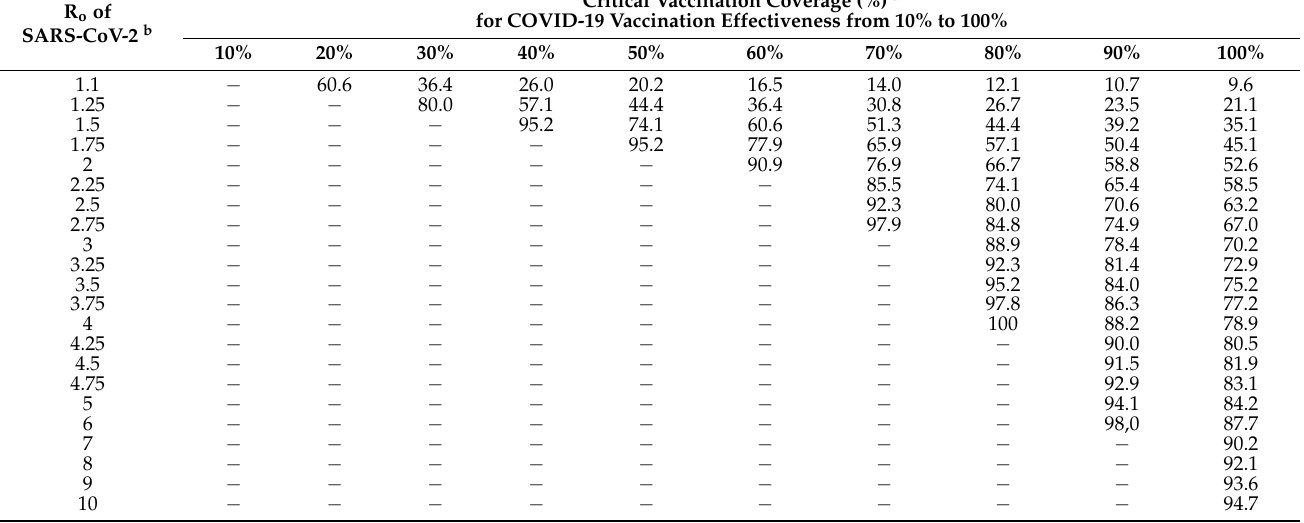
Table 3. Critical vaccination coverage (V c ) required to establish herd immunity against SARS-CoV-2 with reproductive numbers (R o ) from 1.1 to 10 by vaccination effectiveness (%), with 5% of infections among vaccinated